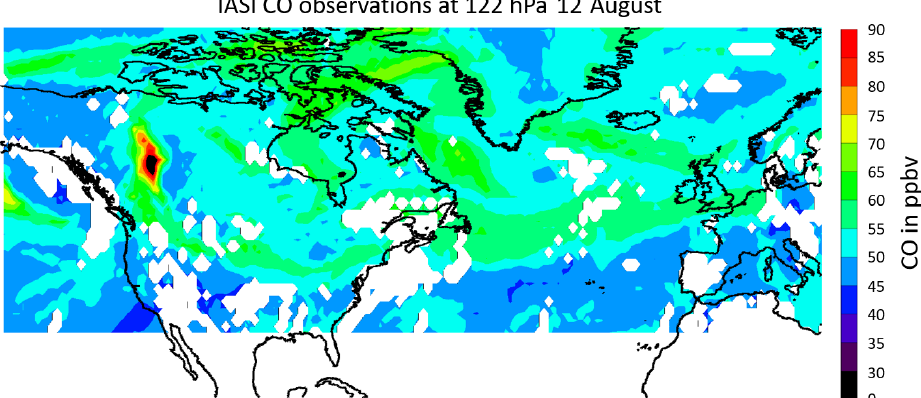
Figure 4. IASI-SOFRID CO mixing ratios at 122hPa for the morning (09:30 local solar time) of 12 August. The high CO plume detected over Canada is used to determine the initialization box chosen for the CLaMS simulation in Fig.